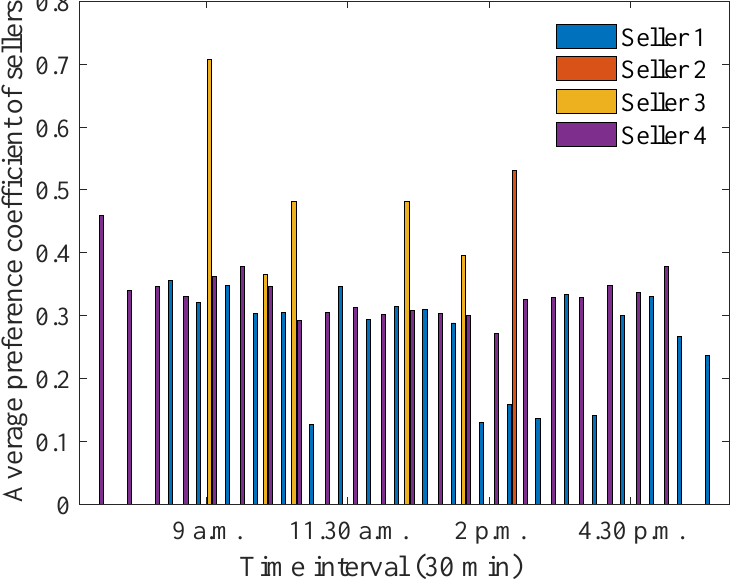
Figure 16. Optimum preference coefficients for sellers when distance between house 1 and the aggregator is